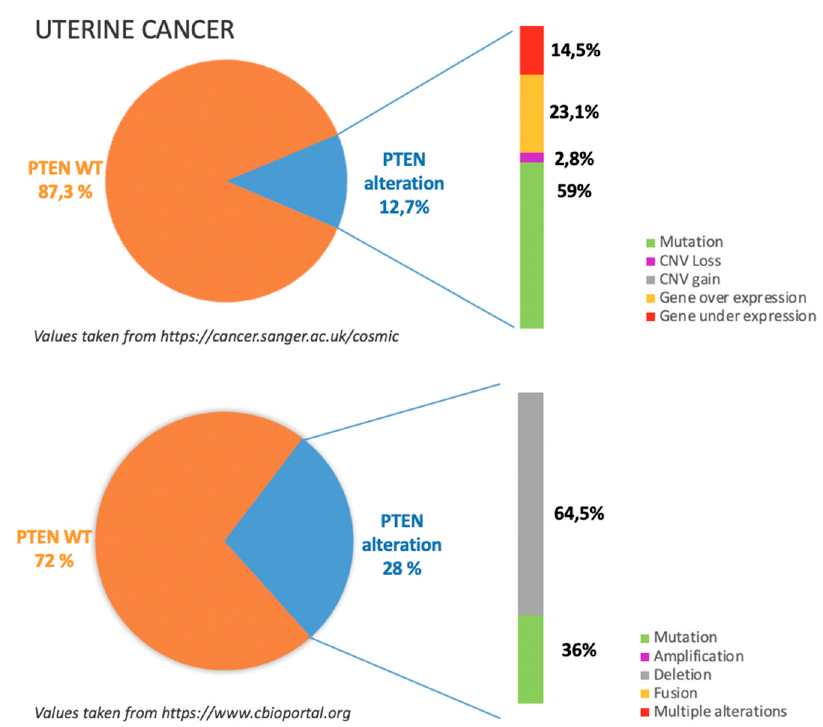
Figure 6. The incidence and type of PTEN alterations according to COSMIC and TGCA datasets in uterine cancer.